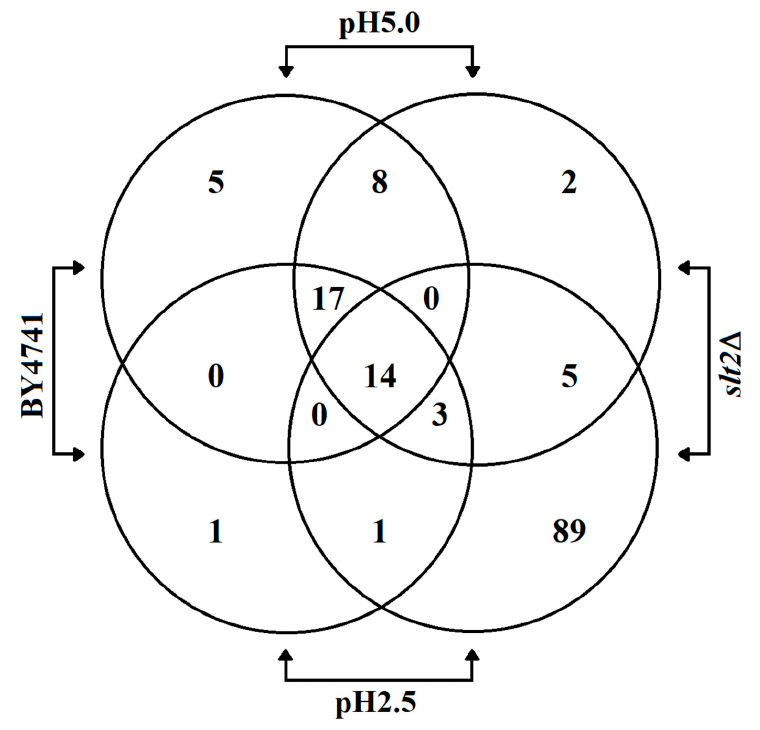
Figure 4. Quantification of overlapping peptides identified in the supernatant of S. cerevisiae BY4741 wild type strain and its isogenic mutant slt2 ∆ cultivated in YNB medium adjusted to pH 5.0 or 2.5 with sulphuric acid.